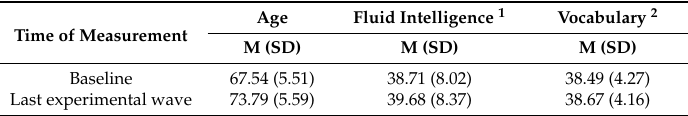
Table 1. Participants’ characteristics at baseline and at the last experimental waves (N =